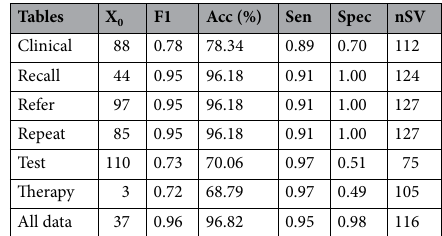
Table 3. Best results obtained from MKL convex optimization combining the four kernels applied independently to the respective data